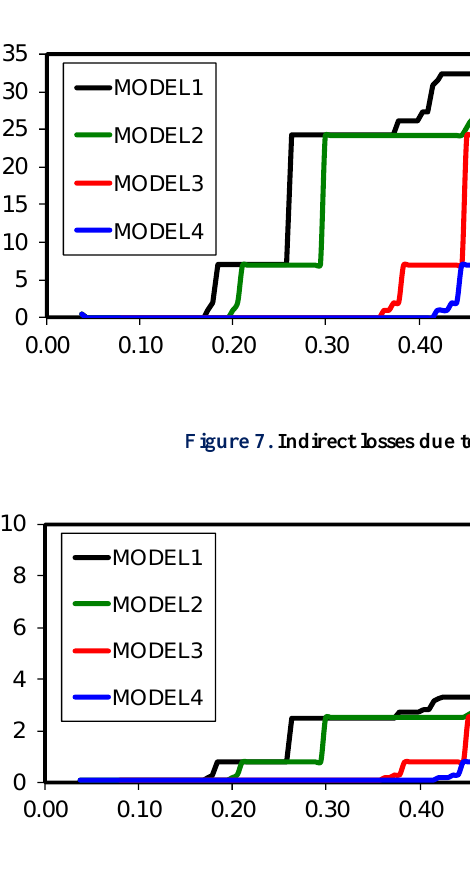
Figure 8. Indirect losses due to prolongation of time (P). Scenario 1: p 2 =0.10.